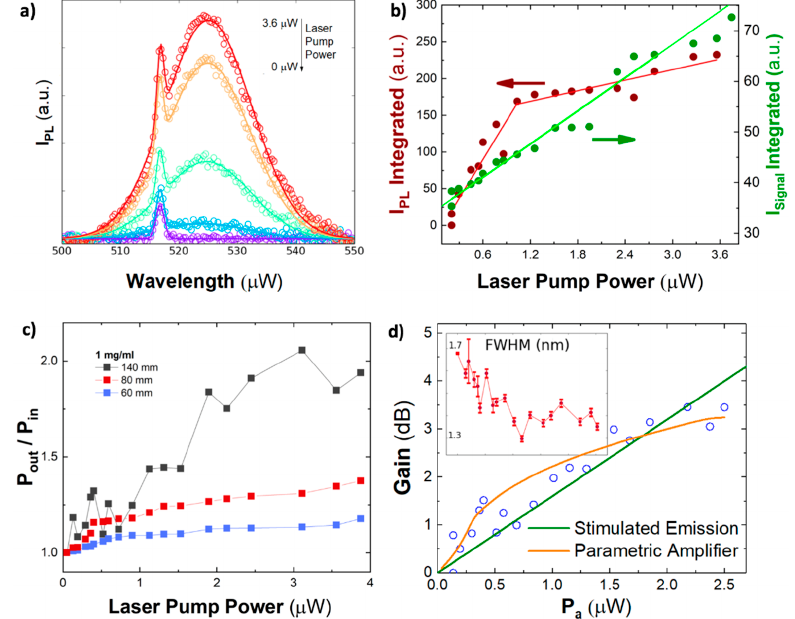
Figure 4. ( a ) Spectra recorded at the extreme of a 140 mm long HC-NCF filled with PNCs (concentration of 1 mg/mL) for different laser pumping powers. Symbols correspond to the experimental data and solid lines to the fitting by the sum of two Gaussian lineshapes (the PL of the PNCs and the regenerated 515 nm laser line, or probe). ( b ) Integrated intensity of the PL (brown circles) and probe (green circles) signals deconvoluted from the spectrum in ( a ) for the 140 mm long HC-NCF. ( c ) Optical amplification ratio P out /P in for different HC-NCF lengths, as a function of the laser pumping power. ( d ) Gain in dB as a function of the excitation in the 140 mm long HC-NCF doped with colloidal PNCs. Continuous curves stand for calculated ASE gain (green line) and parametric amplification (orange line). The inset shows the FWHM of the probe signal with error bars as extracted from fitting experimental curves in ( a ) (the x-axis range is the same as in the main figure).